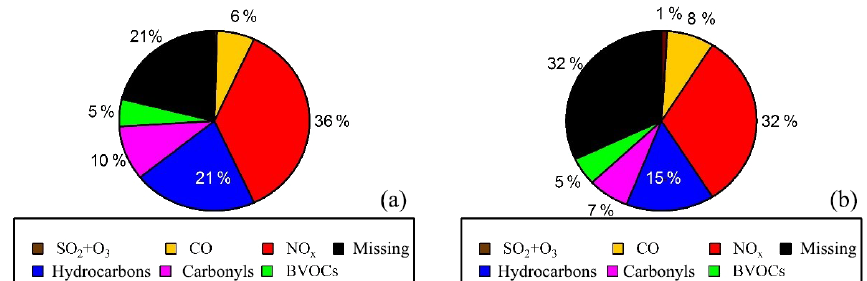
Figure 9. Composition of measured reactivity in Beijing (a) and Heshan (b) .